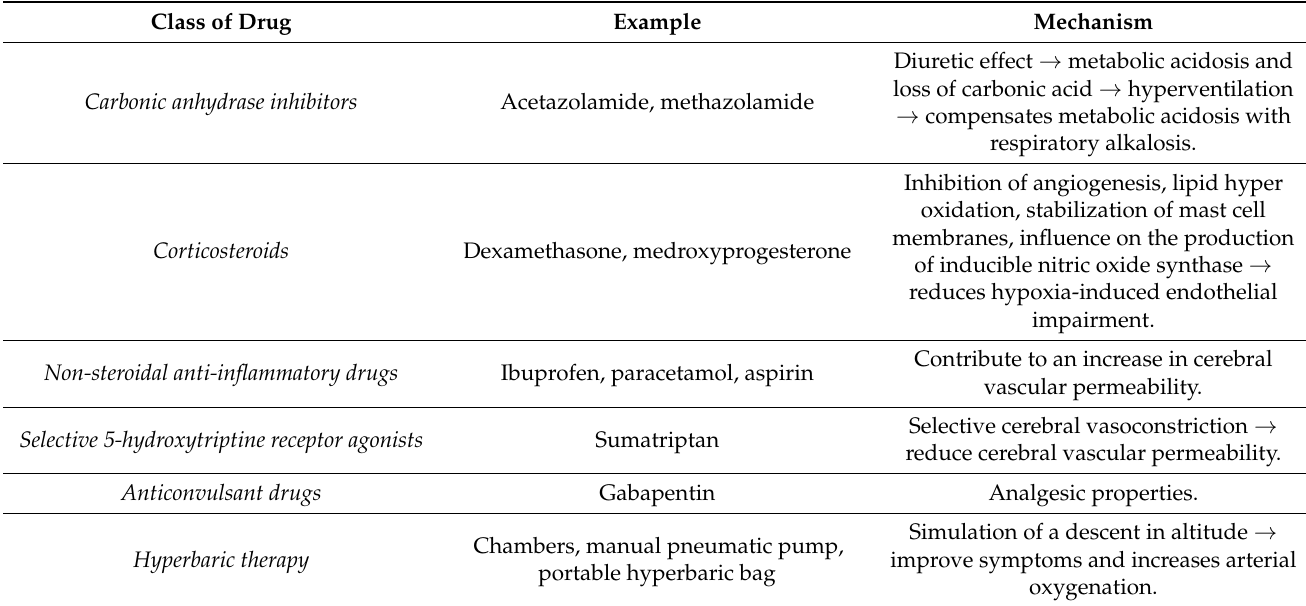
Table 4. Main drugs used for treatment of